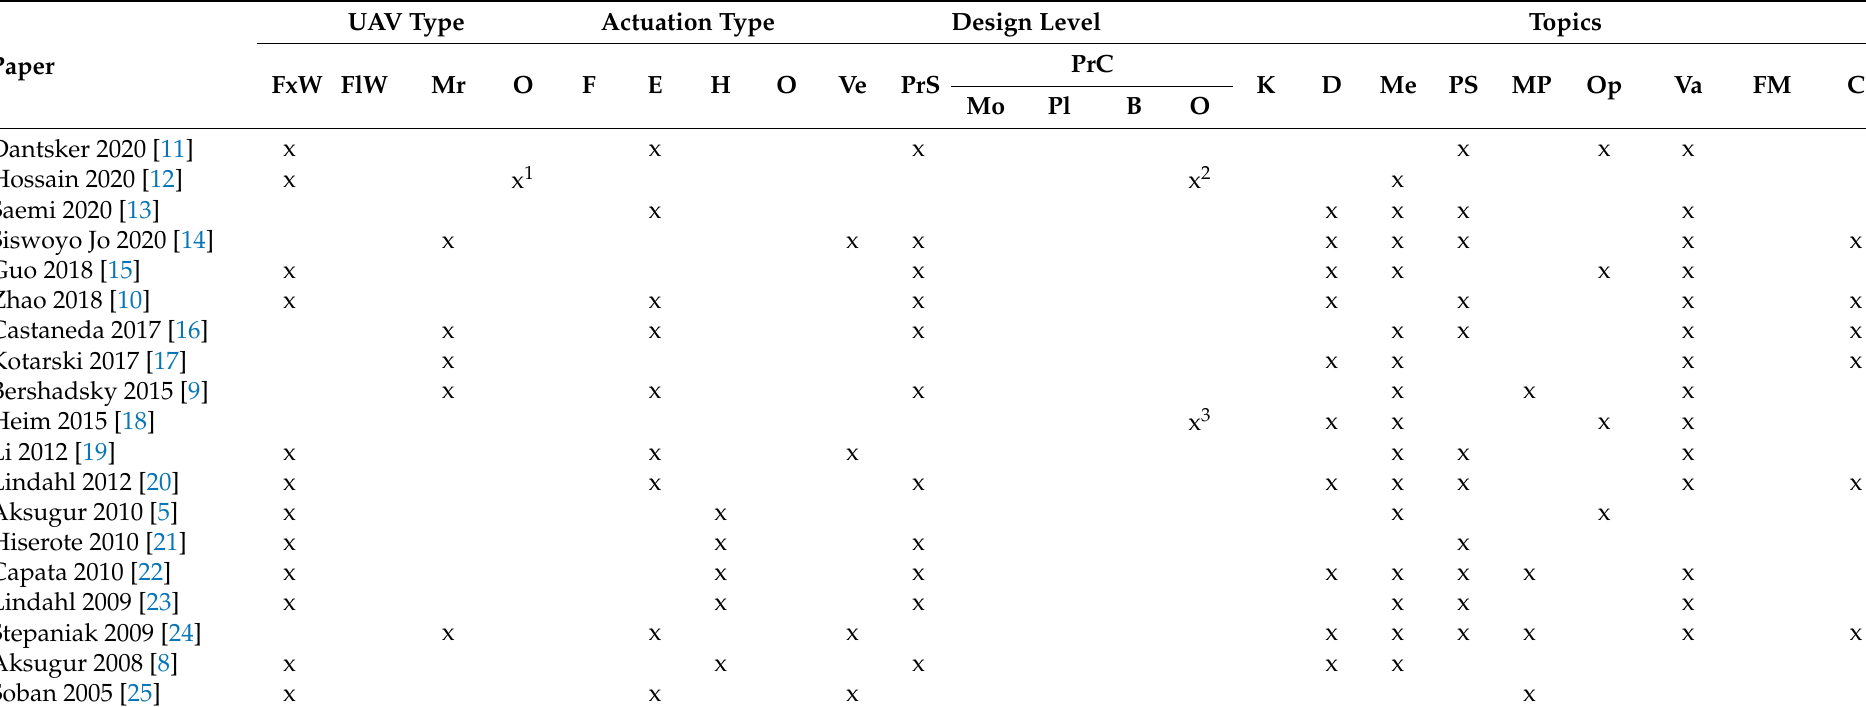
Legend : FxW , Fixed-Wing; FlW , Flapping-Wing; Mr , Multirotor; O , Other; F , Fuel; E , Electric; H , Hybrid; Ve , Vehicle; PrS , Propulsion System; PrC , Propulsion Component; Mo , Motor; Pl , Propeller; B , Battery; K , Kinematics; D , Dynamics; Me , Mechanics; PS , Power Supply; MP , Mission Planning; Op , Optimization; Va , Validation; FM , Fault Maintenance; C , Control. Notes : x 1 Variable-span morphing wing aircraft. x 2 Linear servo-actuated variable-span morphing wing. x 3